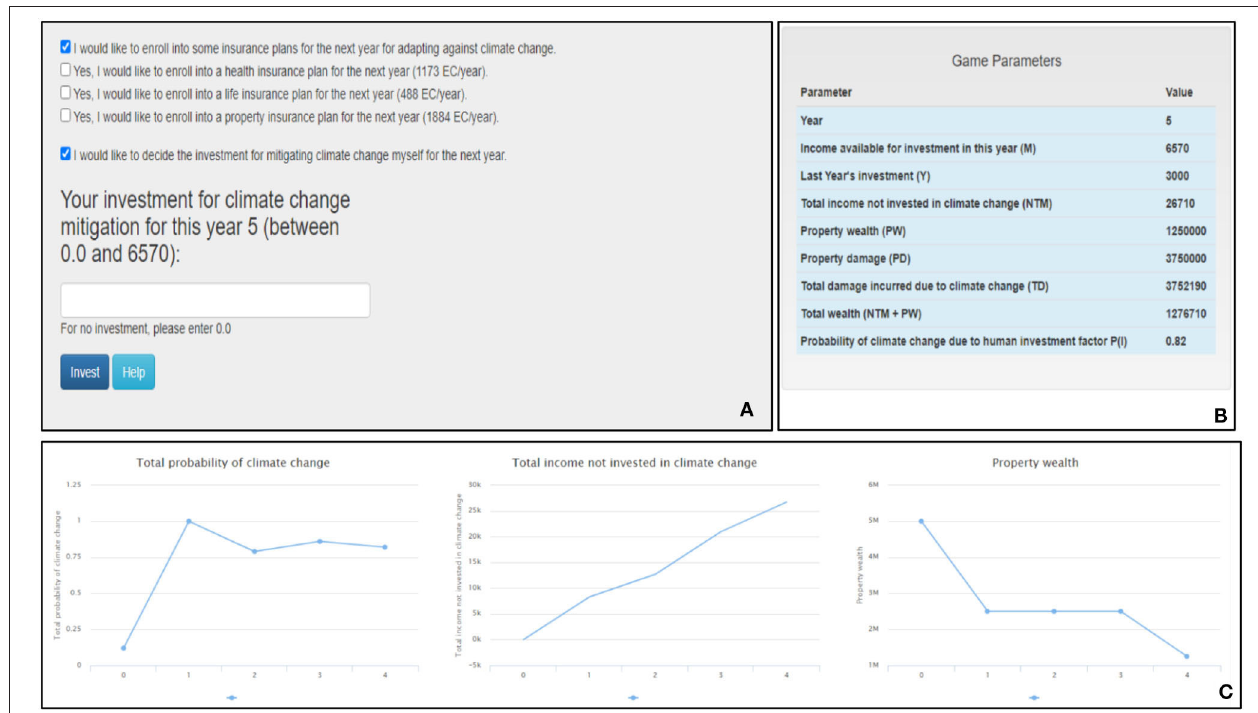
FIGURE 1 | The ICCS tool’s investment screen. (A) Participants make investments against climate change. (B) The tool’s different parameters and their values. (C) Line graphs showing the total probability of climate change, the total income not invested in climate change and the property wealth over years.